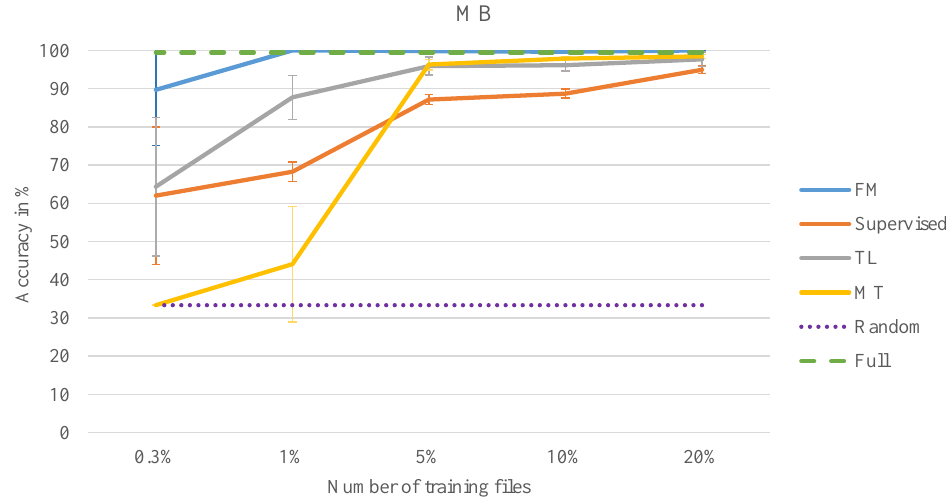
Figure 4. Mean accuracy and standard deviation for FixMatch (FM), fully supervised training (Super- vised), Transfer Learning (TL), and Mean Teacher (MT) on MB test set. Additionally, the supervised baseline using the full training set (Full) and the random baseline are